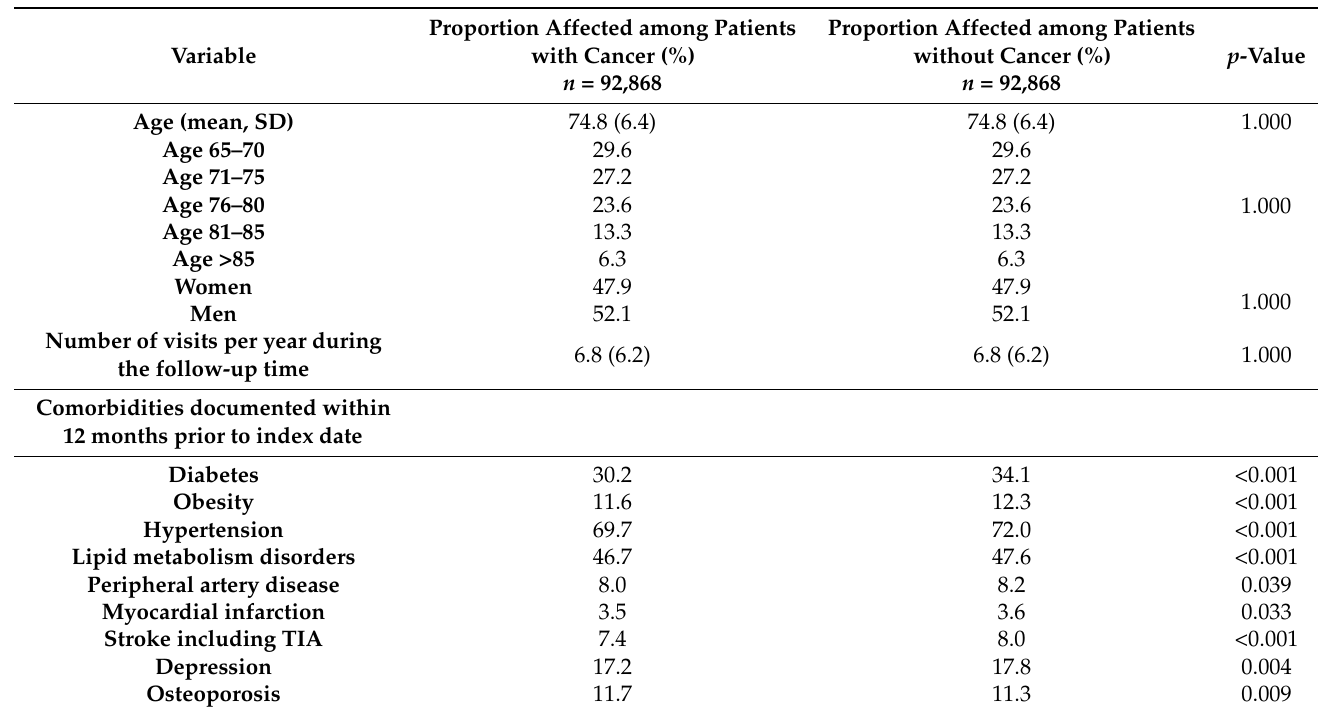
Table 1. Basic characteristics of the study sample after 1:1